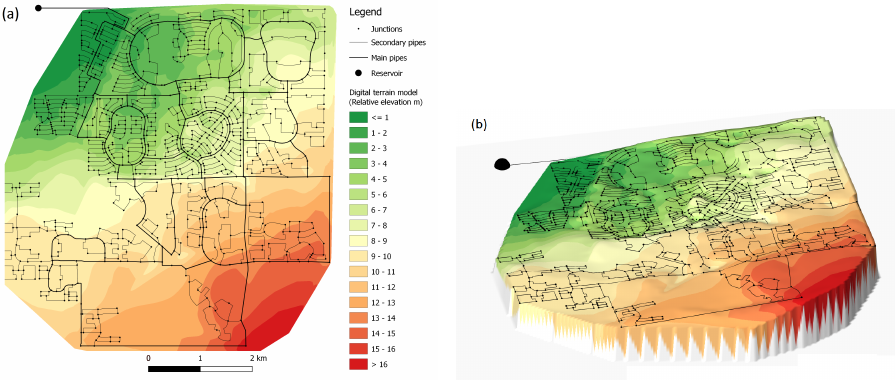
Figure 1. A scheme of the KL network. The WDN is supplied by the reservoir located at the top left. The color scale shows the relative elevation. Main pipes are represented by thicker lines. ( a ) Plan view. ( b ) 3d view, with a vertical scale that has a 50 magnifying factor, to better show the elevation